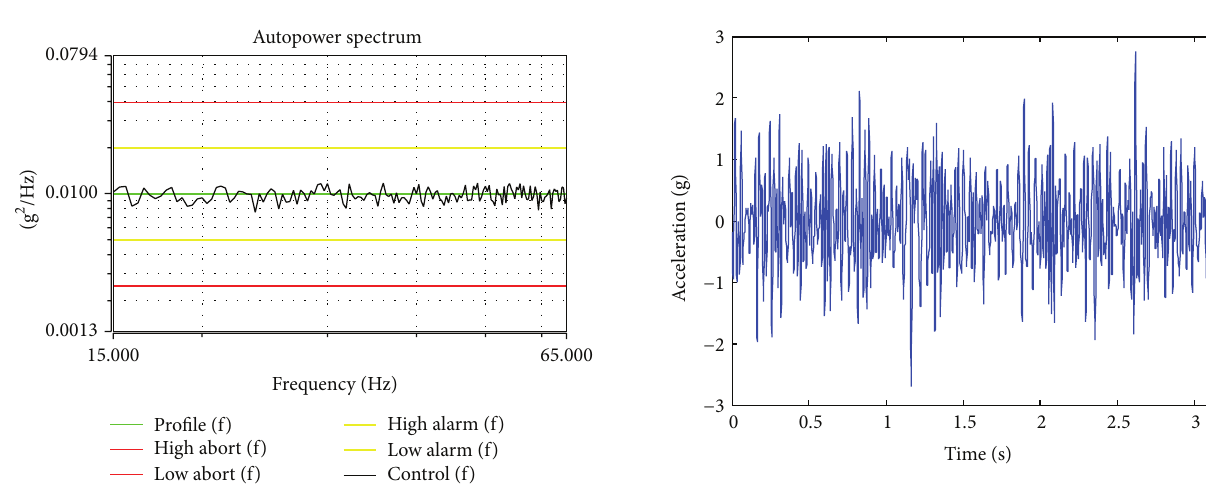
Figure 8: Test profile parameters (B3).